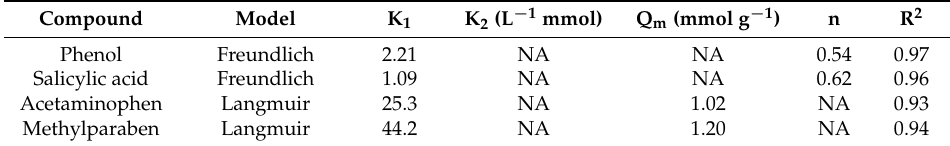
Table 12. Parameters of Langmuir and Freundlich models for phenol, acetaminophen, salicylic acid, and methylparaben adsorption on activated carbon CAR1273.